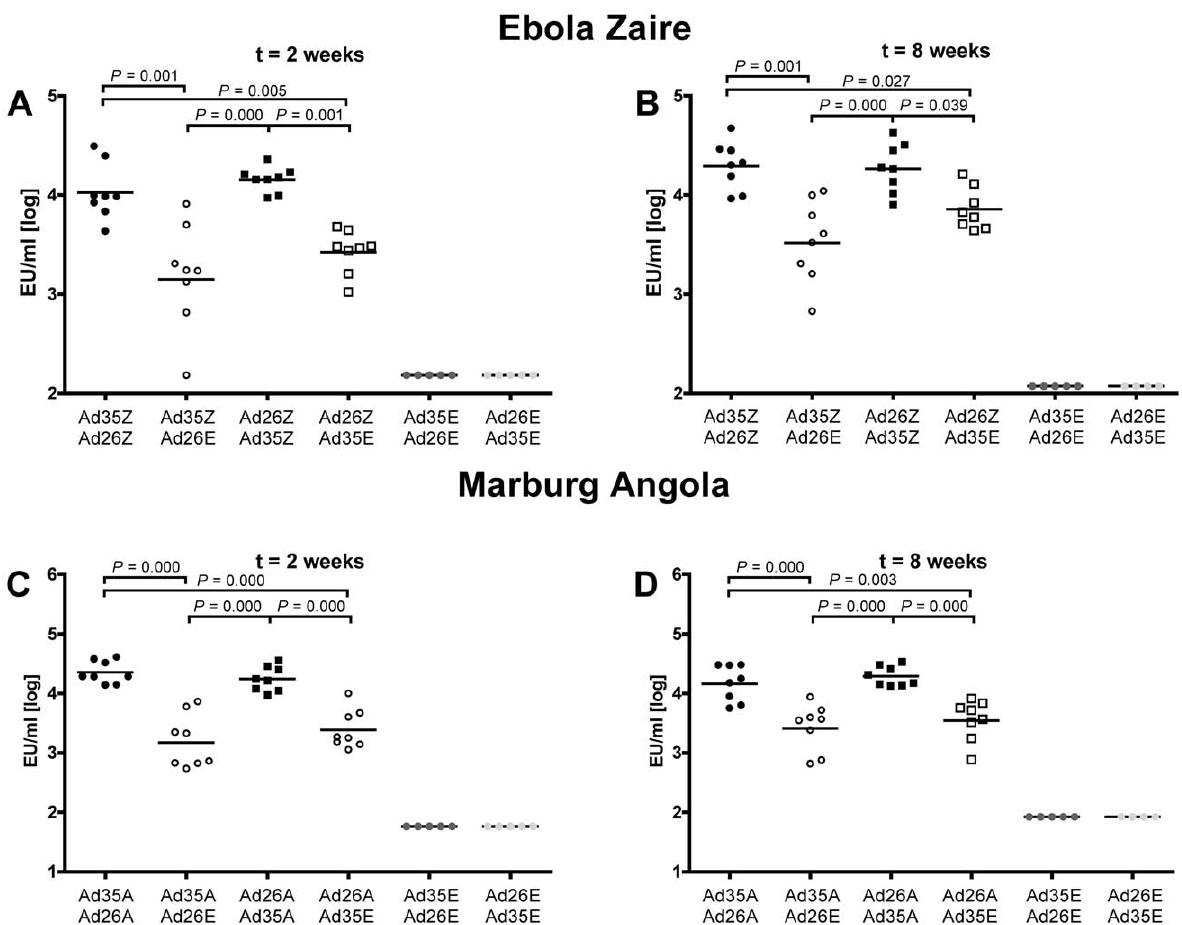
Figure 4. Enhanced filovirus specific humoral immune response to a rAd26/rAd35 prime-boost regimen. The filovirus specific humoral immune response was detected by ELISA. Serum was isolated from groups of mice at two or eight weeks post boost vaccination with 10 10 vp of with vectors coding for Ebola Zaire (A and B), Marburg Angola (C and D), or as control for prime only with a no-antigen coding control vector. The black filled circles represent the group of Ad35.Ebo(Z) or Ad35.Mar(A) primed and Ad26.Ebo(Z) or Ad26.Mar(A) boosted animals; black open circles represent the Ad35.Ebo(Z) or Ad35.Mar(A) primed animals which received the no-antigen coding control vector Ad26.empty as boost. The black filled squares represent the group of Ad26.Ebo(Z) or Ad26.Mar(A) primed and Ad35.Ebo(Z) or Ad35.Mar(A) boosted animals; black open squares represent the Ad26.Ebo(Z) or Ad26.Mar(A) primed animals which received the no-antigen coding control vector Ad35.empty as boost. The dark grey circles represent the control animal group receiving Ad35.empty for prime and Ad26.empty as boost and the light grey circles the animal group receiving Ad26.empty for prime and Ad35.empty as boost. The bar denotes the mean of the log transformed sample titers of eight mice (five for the control groups). The p values given are calculated by Anova and a Post-hoc Tukey